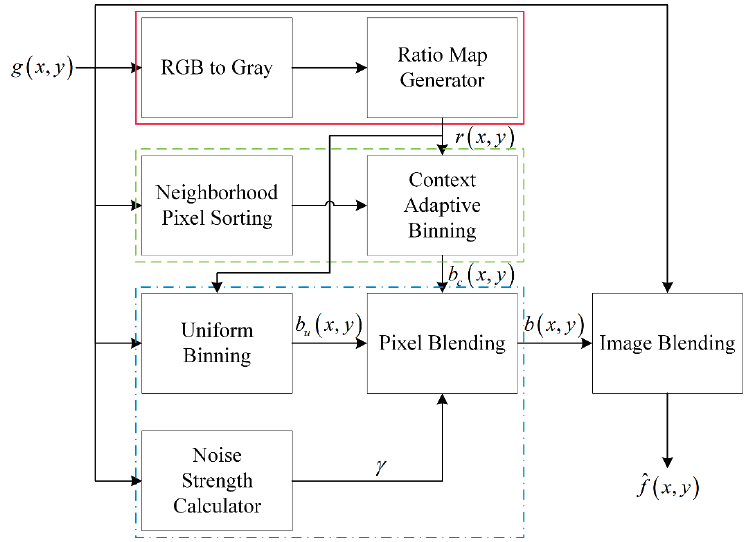
Figure 4. The proposed adaptive digital pixel binning